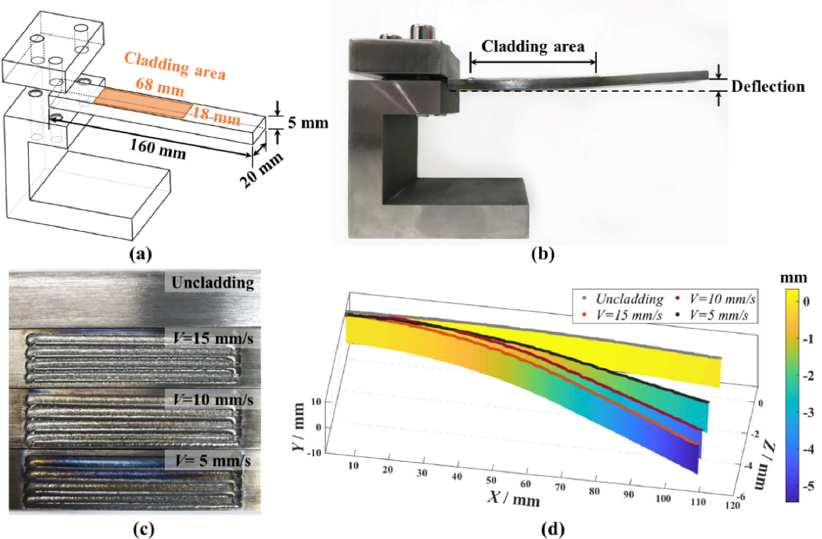
Figure 10. Measurement of cantilever beam deflection. ( a ) Cantilever structure, ( b ) Deflection after printing, ( c ) Printed results at different scanning speeds, ( d ) Deflection at different scanning speeds.